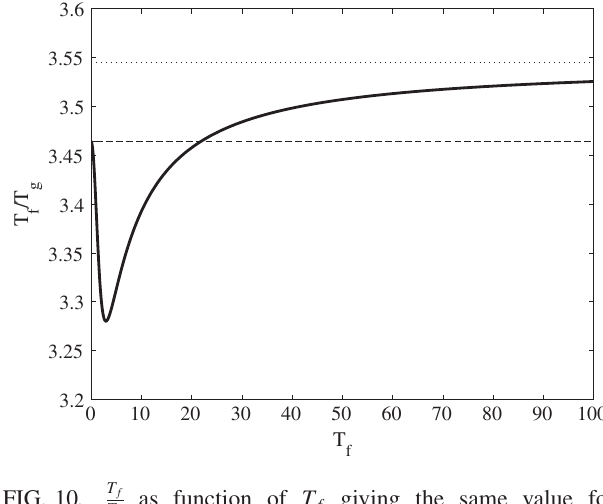
FIG. 10. T f as function of T T g G g 2 ð 0 Þ ¼ G ft 2 ð 0 Þ (bold solid), ffiffiffiffiffiffi p 12 is a good approximation to have the same value G 2 ð 0 Þ for both the flattop and the Gaussian models.